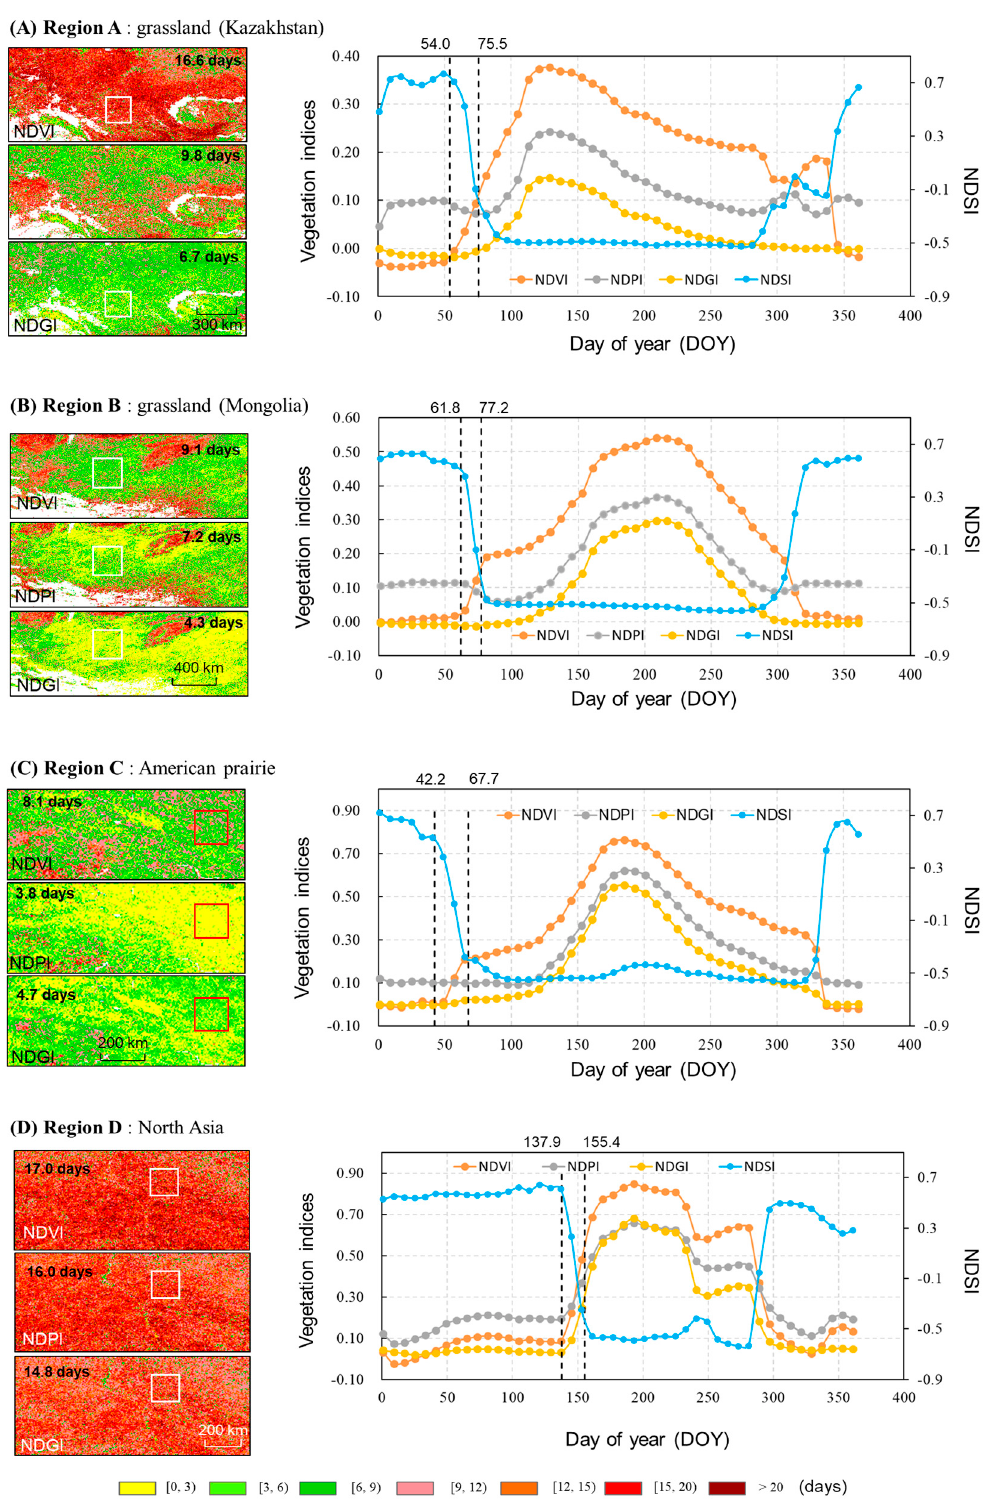
Figure 9. The uncertainty of GUD estimations in the local regions of ( A ) the grasslands of Kazakhstan (Region A in Figure 7), ( B ) Mongolian grassland (Region B in Figure 7), ( C ) American prairie (Region C in Figure 7), and ( D ) Northern Asia forests (Region D in Figure 7). GUD uncertainty averaged over all pixels was also shown in each local region. In the right panels, we showed the time series of NDVI, NDPI, and NDGI. The NDSI time-series data were also included to indicate the period of snowmelt in each region. Noted: The time-series data were generated by averaging all pixels within the white square in the left panels.